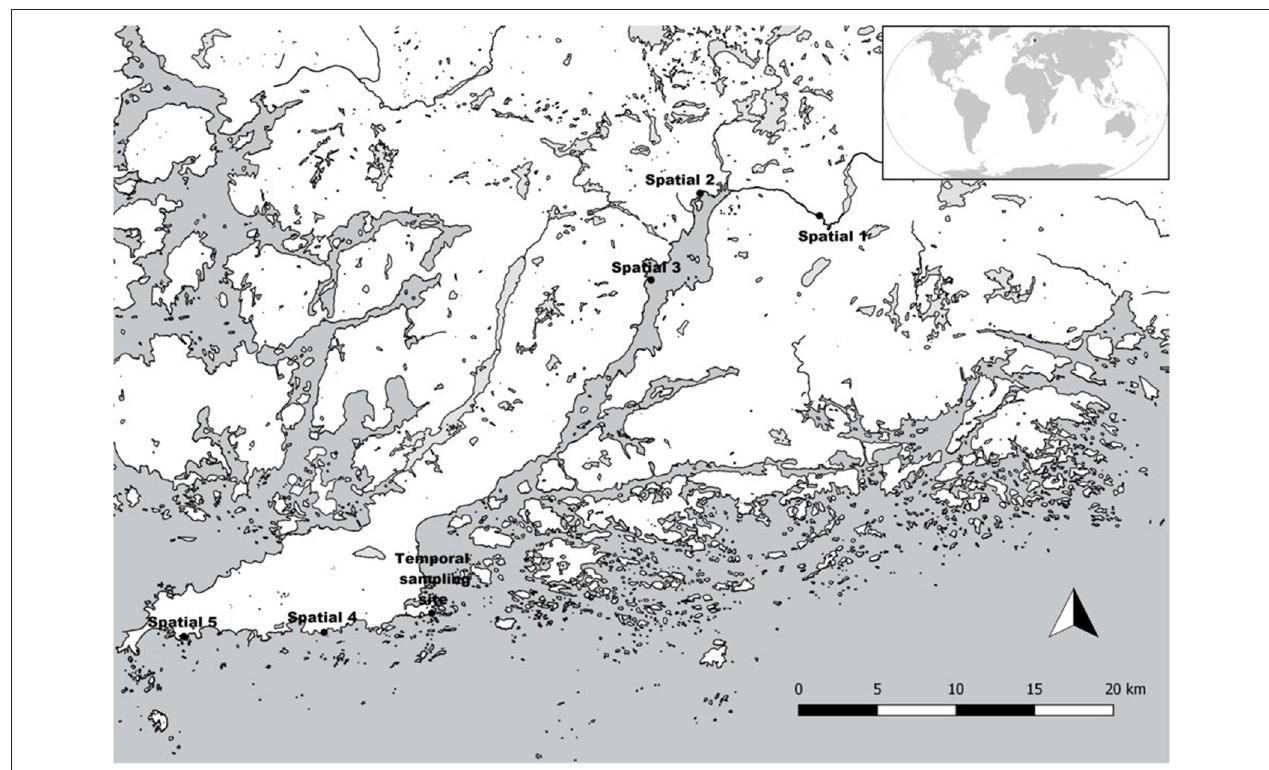
FIGURE 1 | Our temporal sampling site and five spatio-temporal sites along the Hanko Peninsula in southern Finland, Baltic Sea. Map layers derived from HELCOM (2019), European Environment Agency (2019), and SYKE